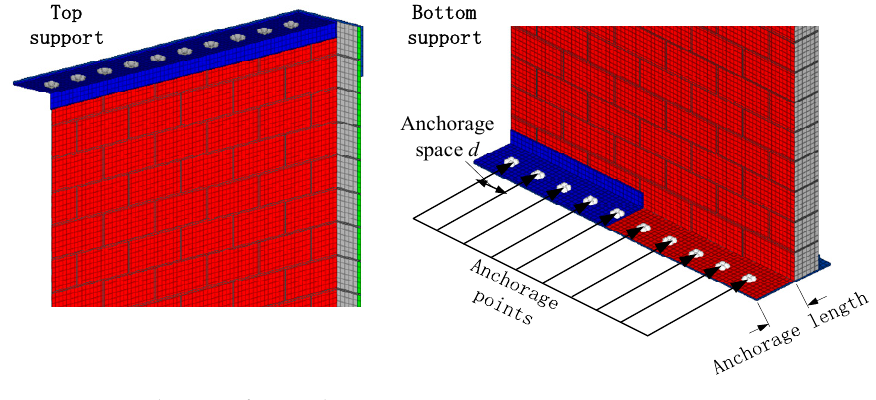
Figure 16. Anchorage of SPUA layer.